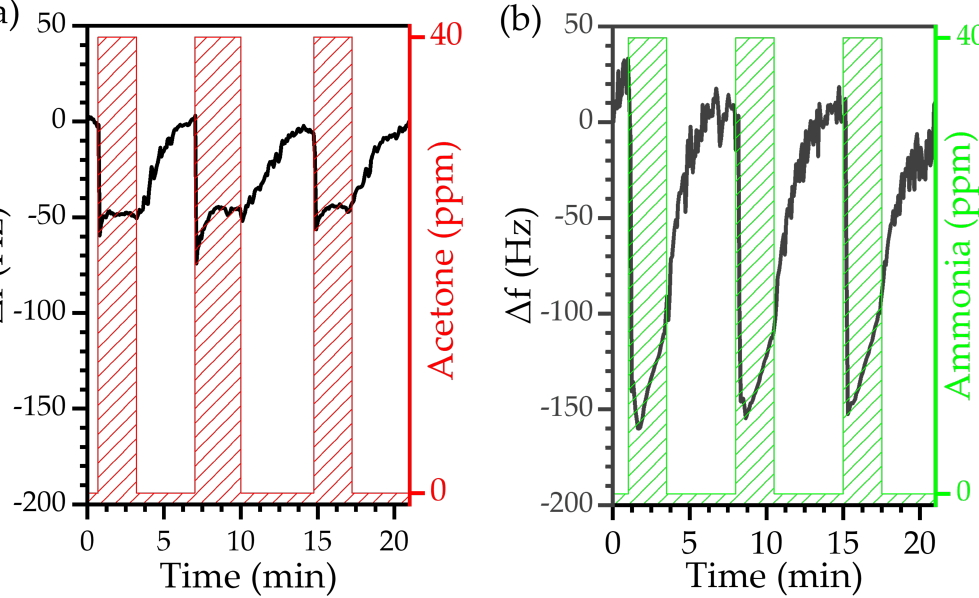
Figure 11. Real-time frequency shift of the device exposed to 40 ppm of ( a ) acetone (gas) and ( b ) ammonia